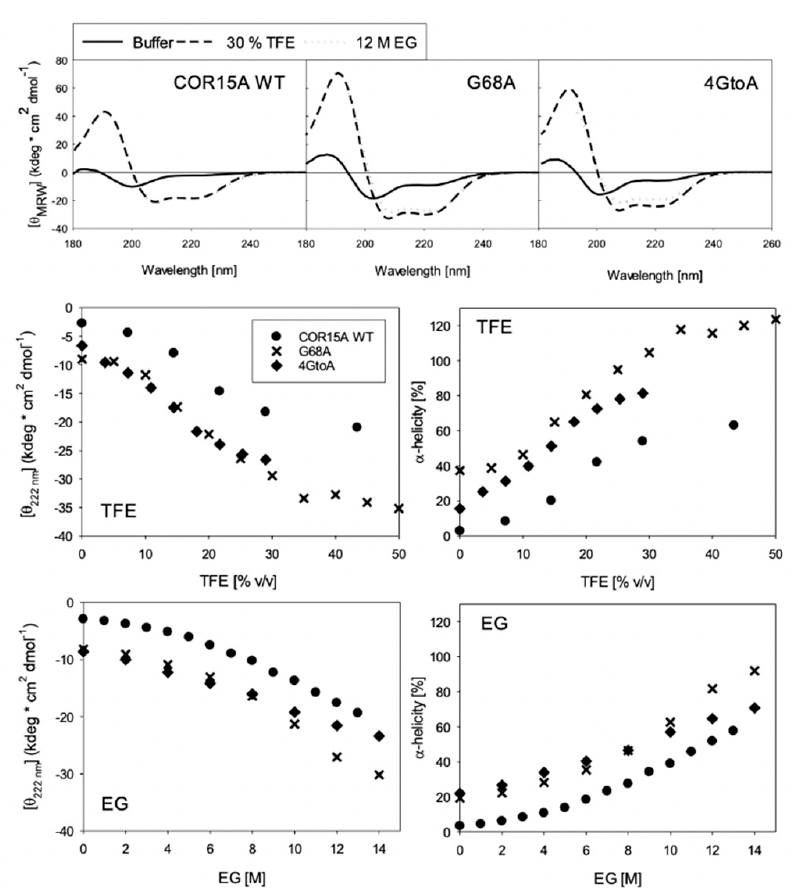
Figure 7. Far-ultraviolet (UV) circular dichroism (CD) spectra in buffer, 20 ( v / v ) % TFE and 12 M Ethylene Glycol for COR15A WT, G68A and 4GtoA ( A ). The mutants have more α -helical spectra than the WT in buffer alone, and in the presence of high concentrations of both co-solvents. Coil-helix transitions of COR15A WT and both mutants in TFE ( B ) and EG ( C ), specified by θ MRW at 222 nm (left panels) and derived α -helix ratios (right panels).